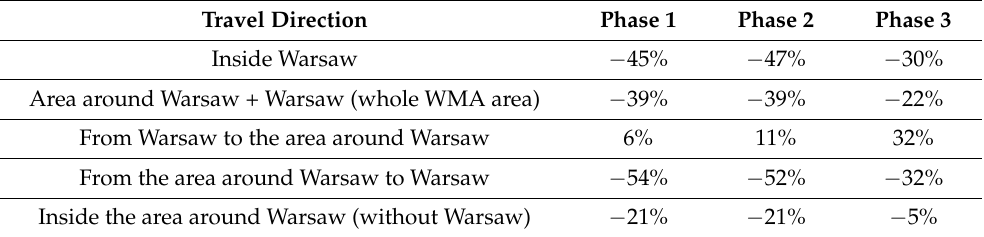
Table 2. Decrease (-) or increase in the number of trips in the morning peak hour in the WMA zone itself in 2020 during the three pandemic phases with respect to 2019.